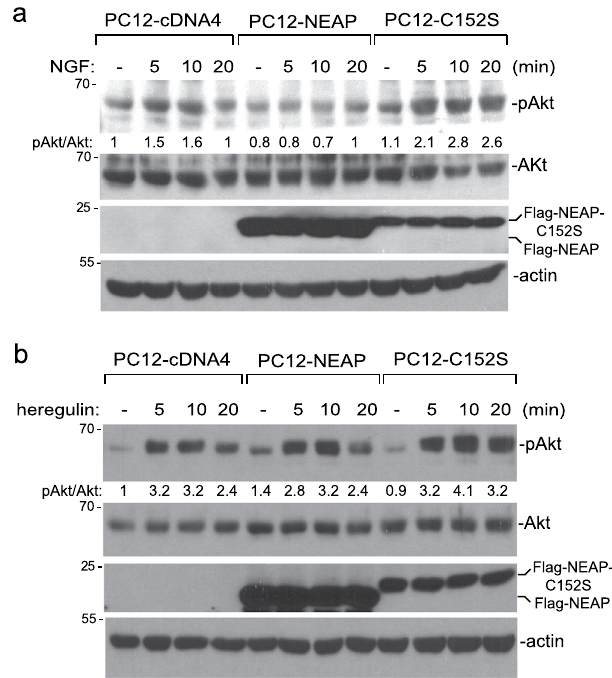
Figure 1. NEAP suppresses NGF-, but not heregulin-, induced Akt phosphorylation. ( a and b ) PC12-cDNA4, NEAP, or NEAP-C152S cells were treated with NGF (50 ng/ml) and the cells were collected at the indicated time points. Proteins of interest in the extracts were examined by immune-blotting assays using specific antibodies. Phospho-protein intensity was normalized by the level of the corresponding protein in the same sample. The phospho-protein/protein ratio in the untreated PC12-cDNA4 cells was designed as 1. The results from two independent experiments were presented in Supplementary